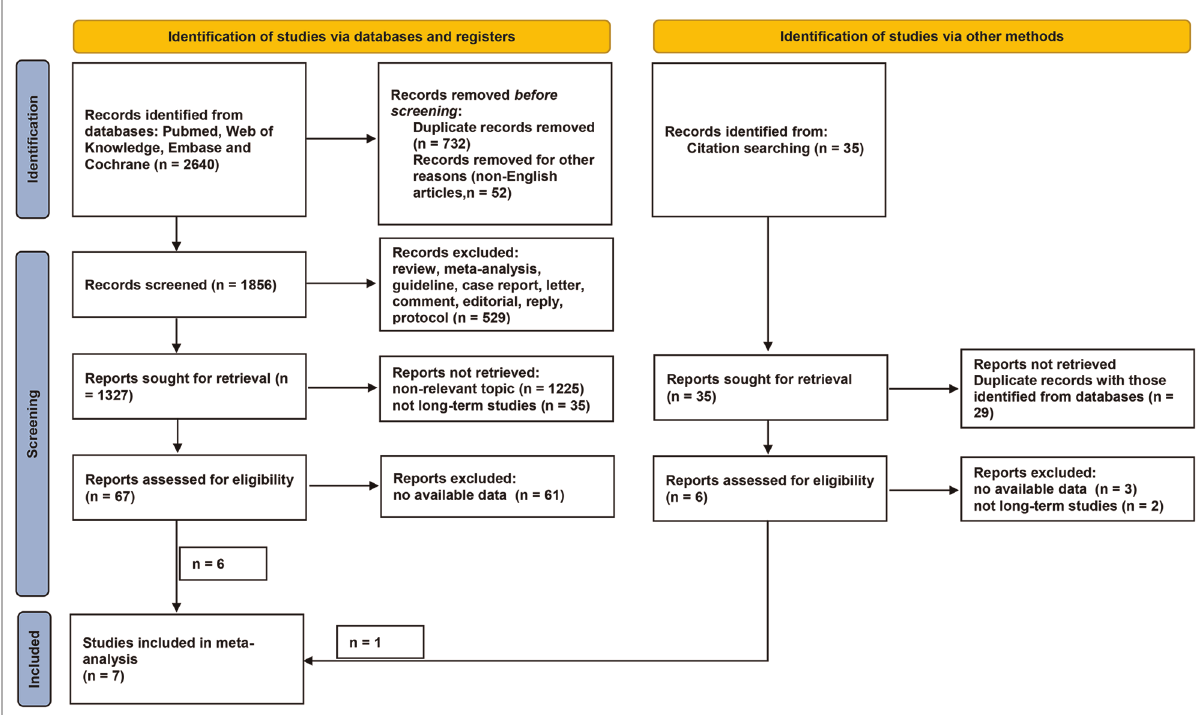
FIGURE 1 Flow diagram of literature selection. Records were identi fi ed via databases ( n =2,640) and other methods (citation searching, n =35). After screening, a total of six and one records were considered eligible for inclusion from databases and other methods, respectively. Finally, seven studies were included in the present